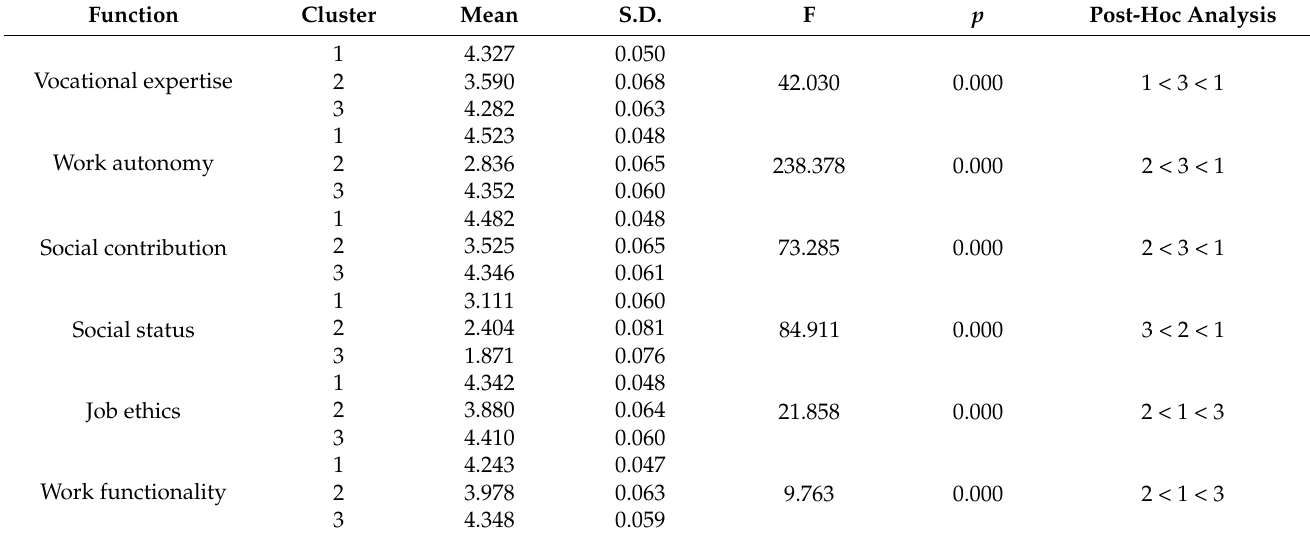
Table 5. Results of differences between clusters by Professionalism perception.